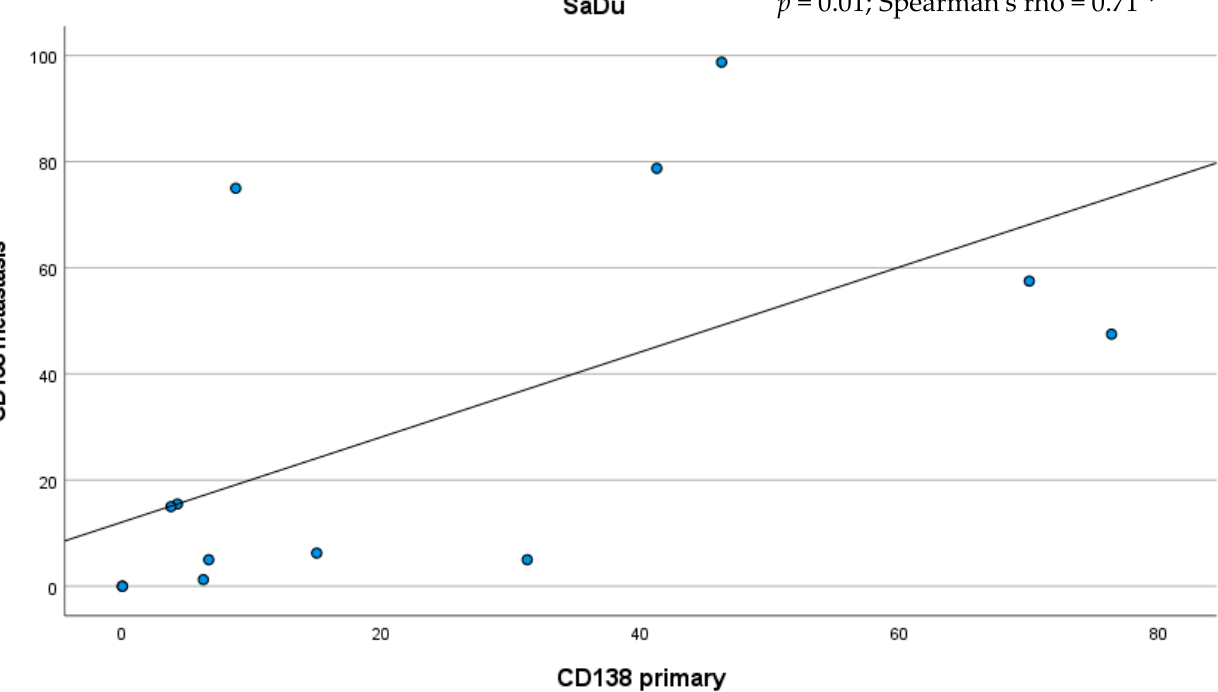
Figure 5. Scatter plot displaying the correlation between the percentage of CD138-expressing tumor cells in salivary duct carcinoma (SaDu) primaries and their lymph node metastases. * Spearman’s rank correlation coefficient.